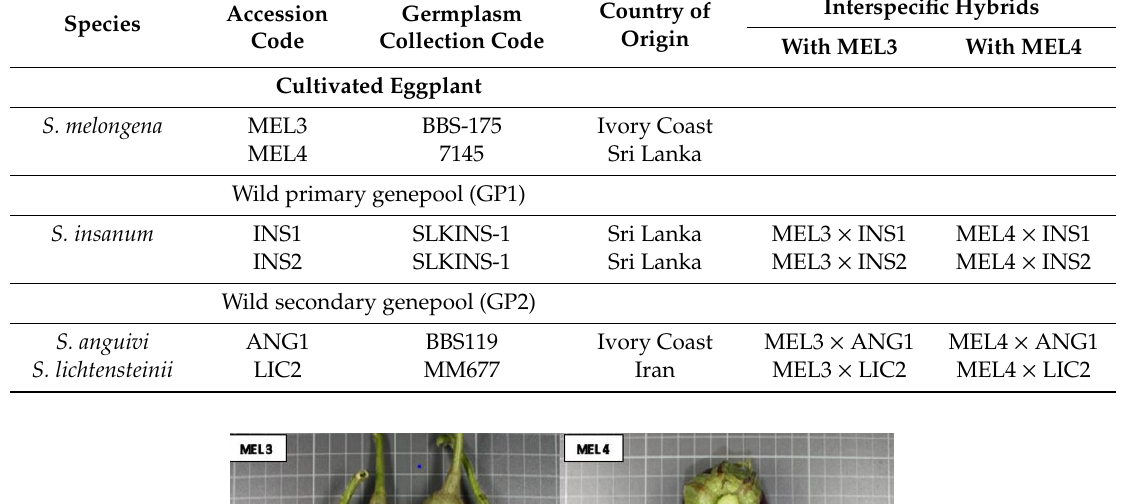
Table 1. Accessions of cultivated eggplant (lines) and wild relatives (testers) used for the line by tester analysis.